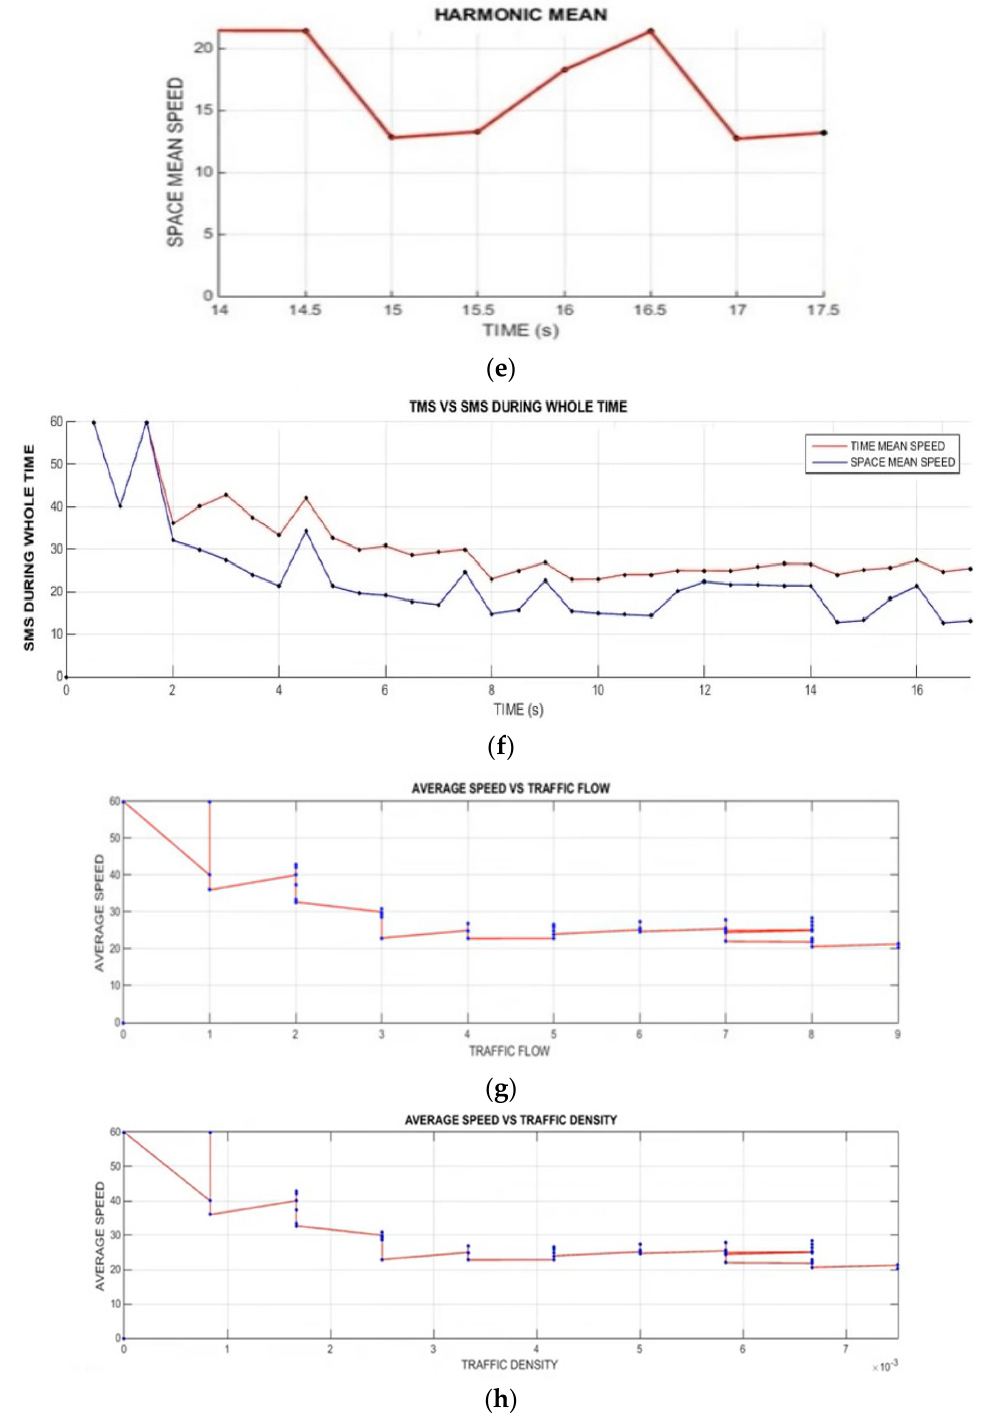
Figure 12. Simulation results for scenario 1 only with LAVs (From Figure 12a–h). ( a ) Traffic congestion; ( b ) space utilization; ( c ) traffic jam ratio; ( d ) time mean speed; ( e ) harmonic mean; ( f ) time means speed vs. space means speed; ( g ) scenario 1 results for average speed vs. traffic flow. ( h ) Scenario 1 results for average speed vs. traffic density.